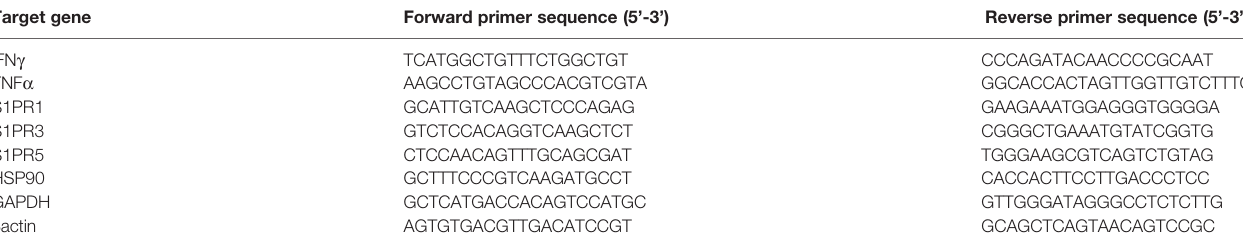
TABLE 1 | Target genes and their primer pairs. Target